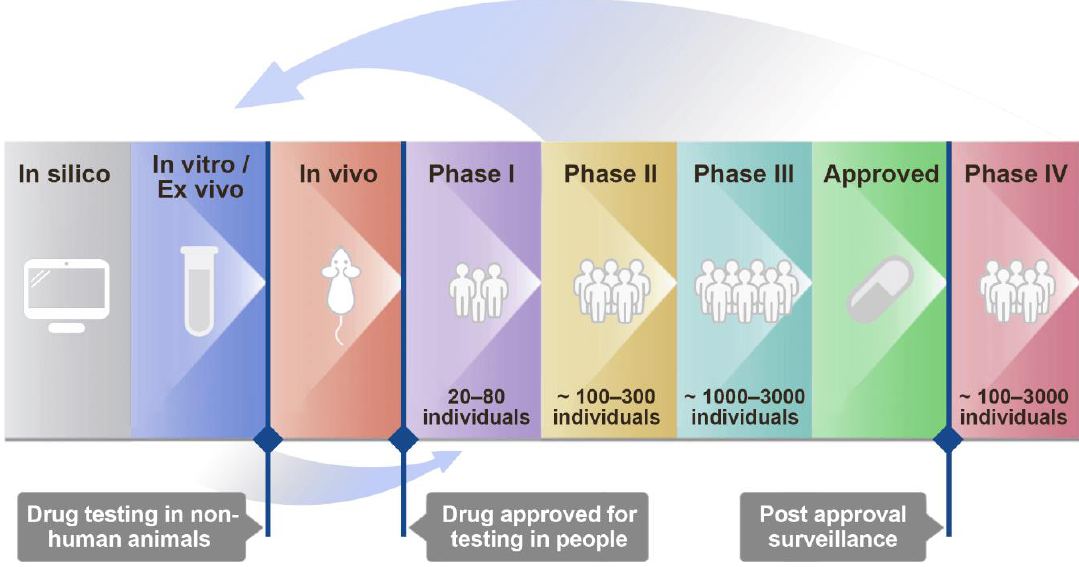
Figure 1. Discovery and development of antiviral drug combinations for treatment of viral infections.